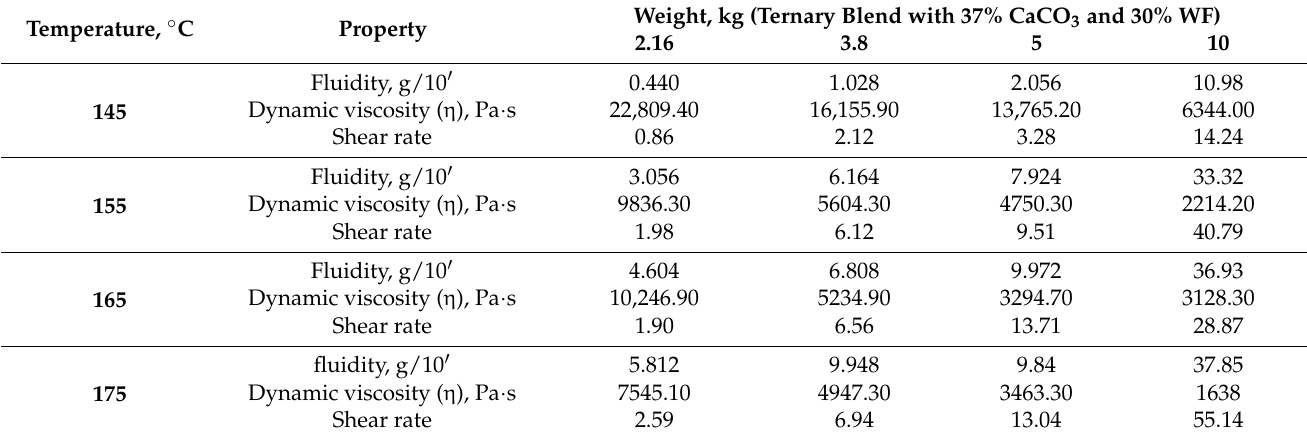
Table 7. The flow melt properties of the quaternary selected blend with CaCO 3 and 30% wood flour. Temperature, ◦ C